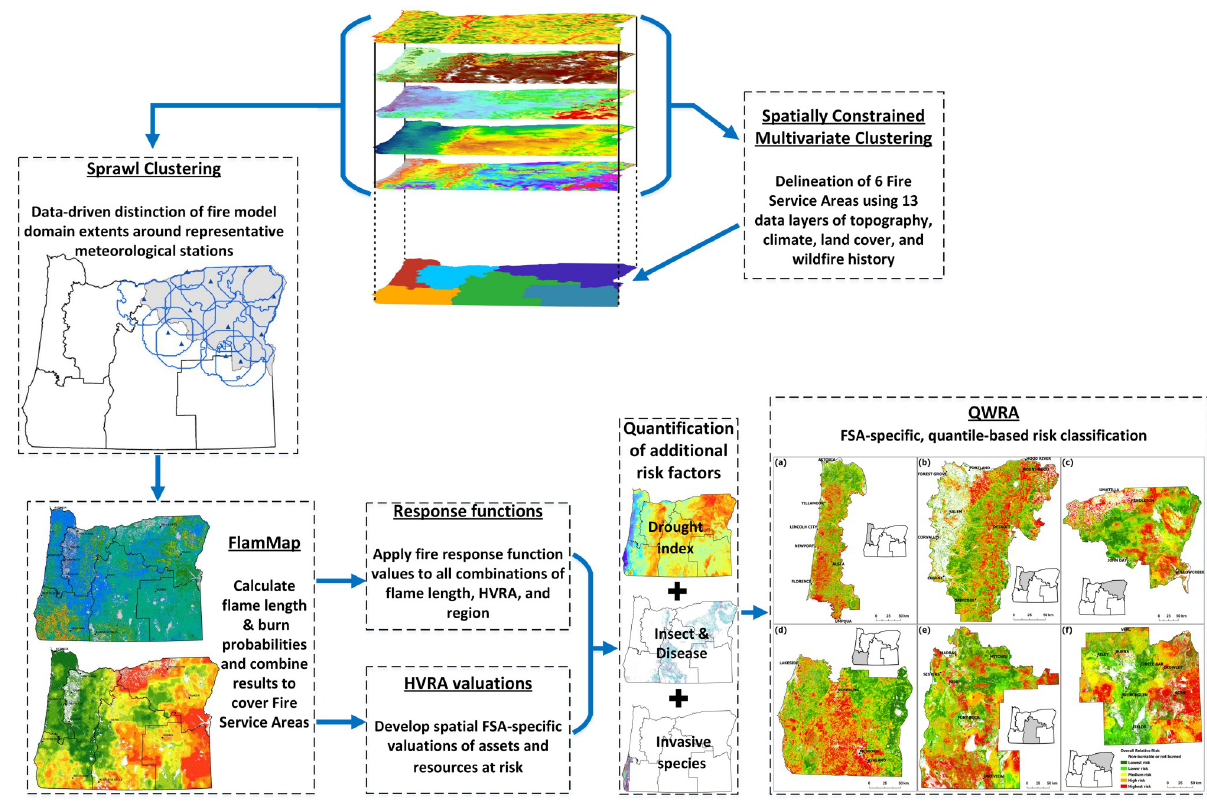
Fig 1. Schematic overview of the processes conducted for the risk